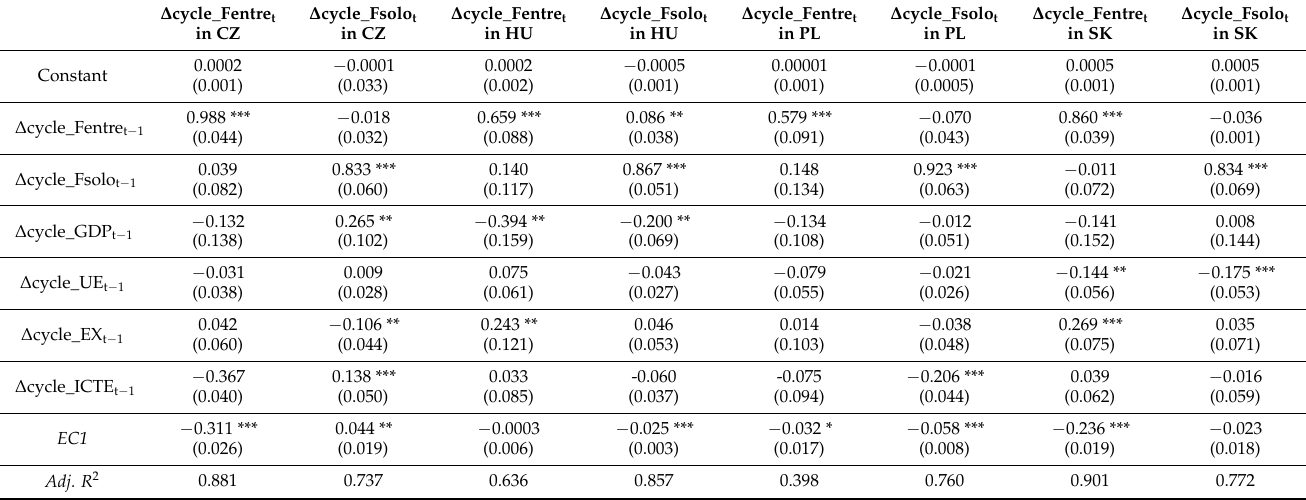
Table 4. Parameters of regression function estimations of cyclical